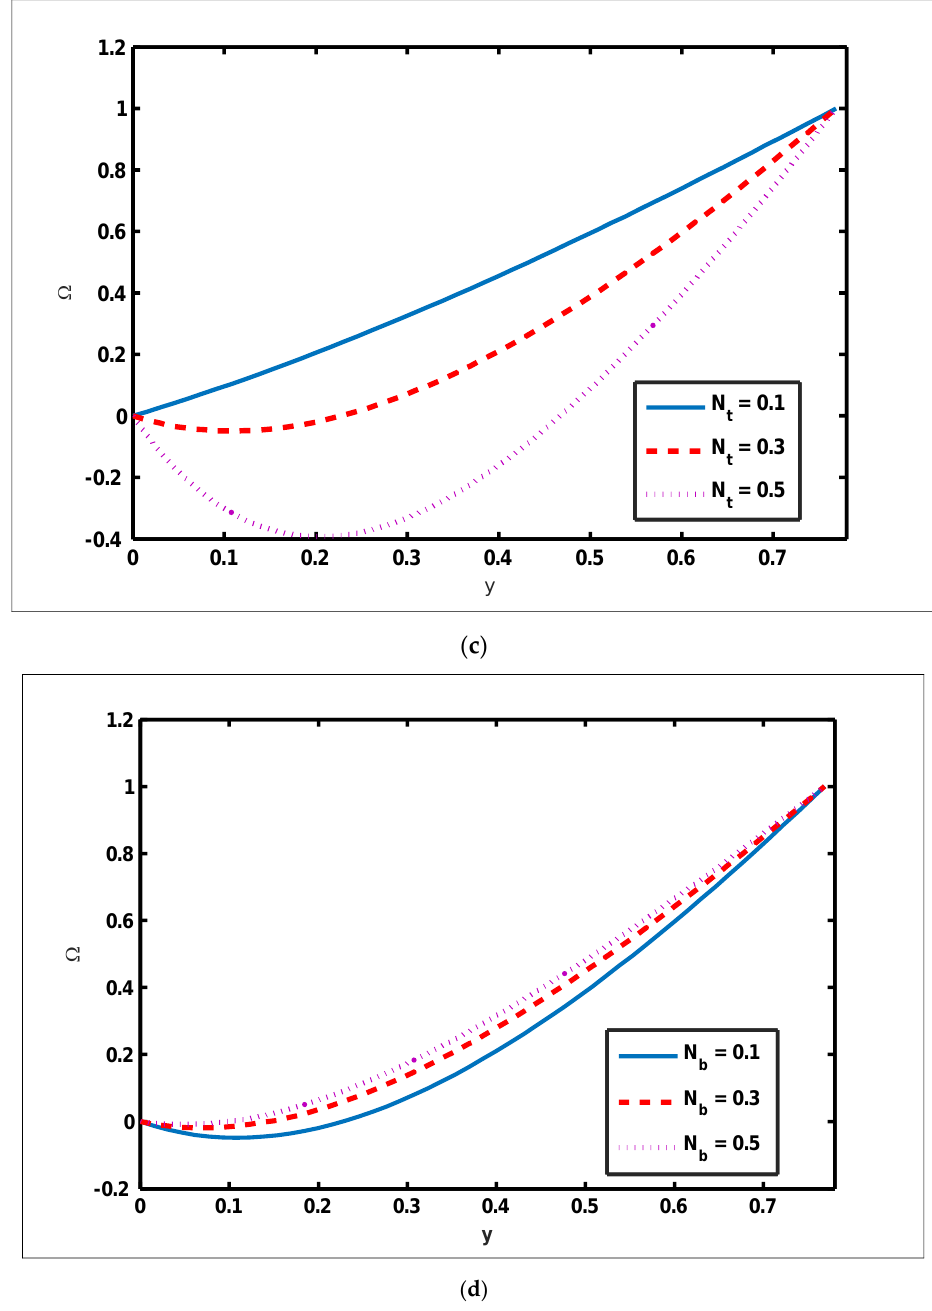
Figure 3. Profile of nanoparticle fraction for Soret, Dufour, thermophoresis, and Brownian motion parameters. Values of other physical parameters are ( a ) 𝑁 𝑡 = 0.3, 𝑁 𝑇𝐶 = 1.2, 𝑁 𝑏 = 0.3,𝑏 = 0.7, 𝑎 = 0.3, 𝑥 = 0.6. ( b ) 𝑁 𝑏 = 0.2,𝑁 𝑡 = 0.3, 𝑁 𝐶𝑇 = 0.9, 𝑏 = 0.7, 𝑎 = 0.3,𝑥 = 0.6. ( c ) 𝑁 𝑡 = 0.3,𝑁 𝑇𝐶 = 1.2,𝑁 𝐶𝑇 = 0.9, 𝑏 = 0.7,𝑎 = 0.3,𝑥 = 0.6. ( d ) 𝑁 𝑏 = 0.2, 𝑁 𝑇𝐶 = 1.2, 𝑁 𝐶𝑇 = 0.9, 𝑏 = 0.7,𝑎 = 0.3,𝑥 = 0.6.